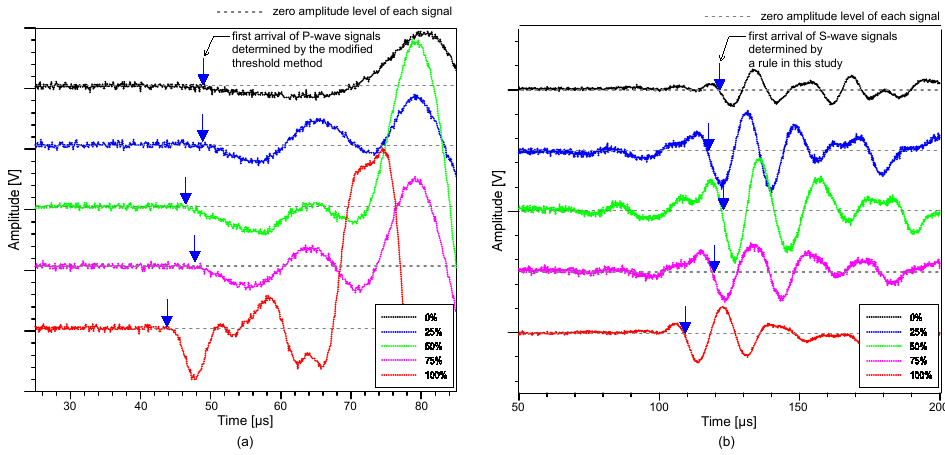
Figure 3. Typical time signals of ultrasonic pulse waves propagating through the MIX 1 concrete cylinders with various water saturation conditions: ( a ) P-wave and ( b ) S-wave signals.